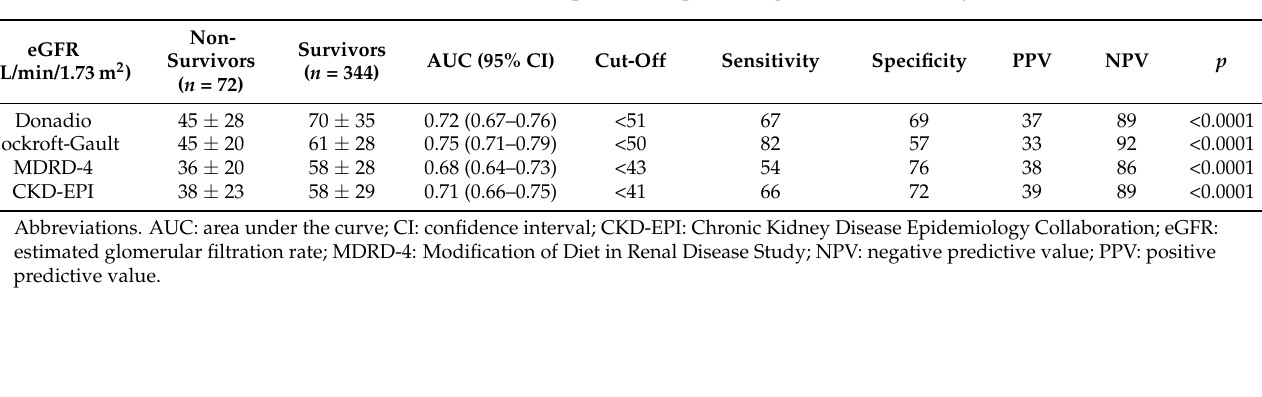
Table 2. Performance of eGFR equations in predicting all-cause